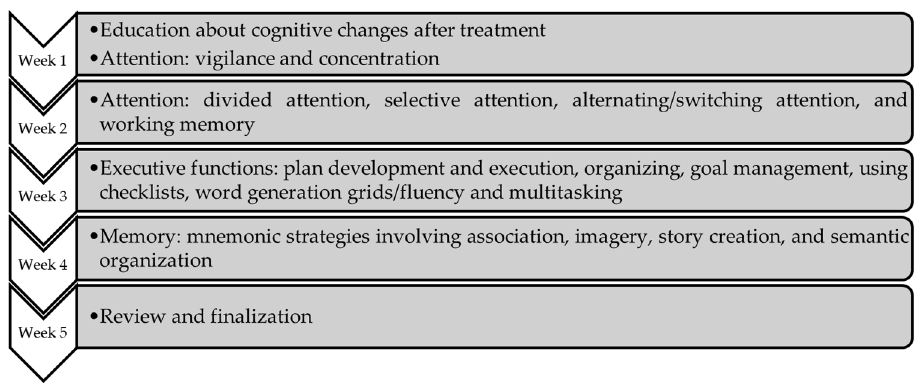
Figure 1. Overview of the UCLA Cognitive Rehabilitation Intervention Program contents and struc ‐ ture. Table 1. UCLA Cognitive Rehabilitation Intervention